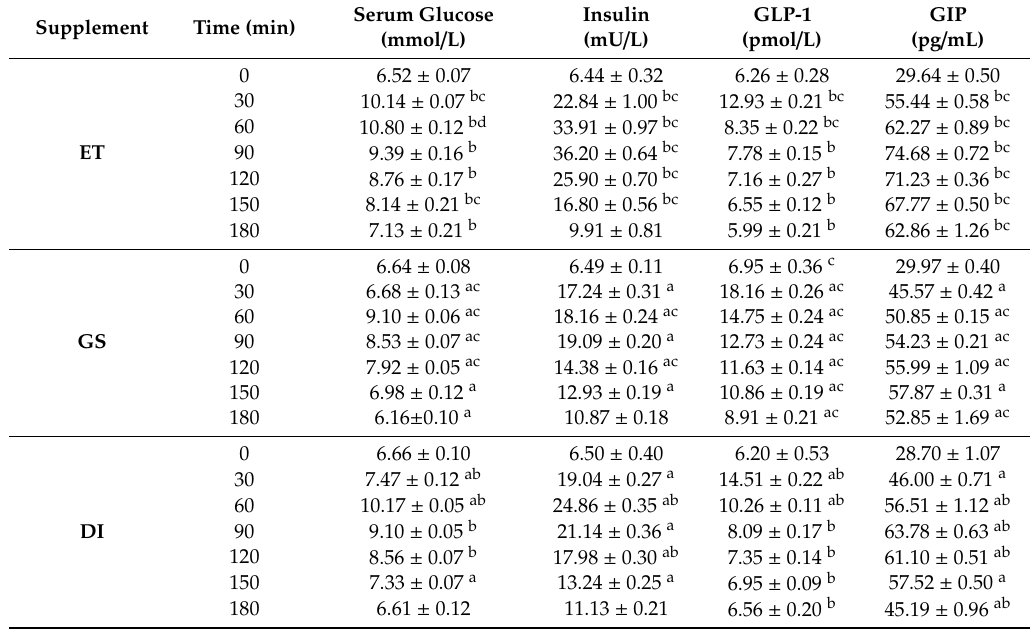
Table 4. Serum glucose concentration and EIAP according to each